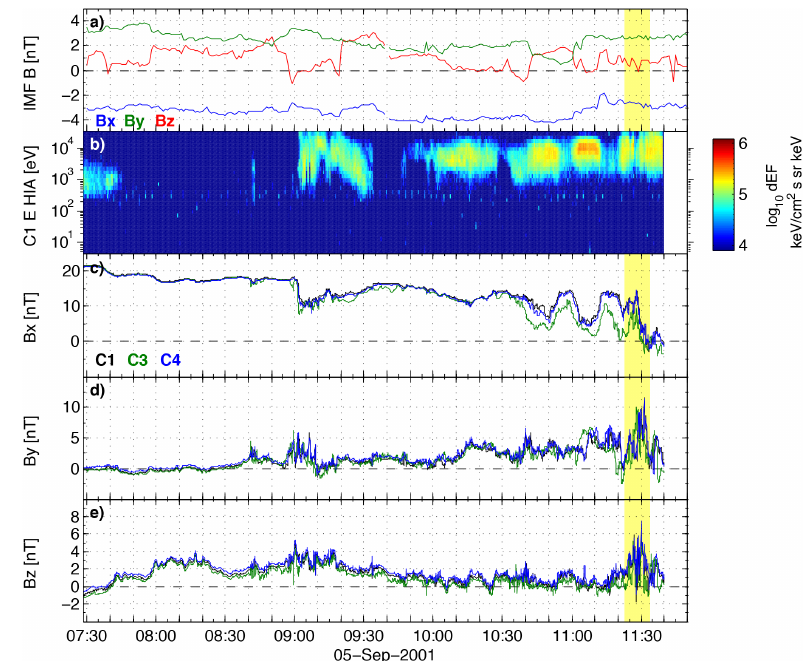
Figure 4. (a) IMF components, (b) Cluster C1 HIA omni-directional ion energy spectrogram, and (c – e) Cluster B field components during the ∼ 4h period prior the fast flow event occurring at ∼ 11:22–11:34UT on 5 September 2001. The time interval of the fast flow event is marked by yellow